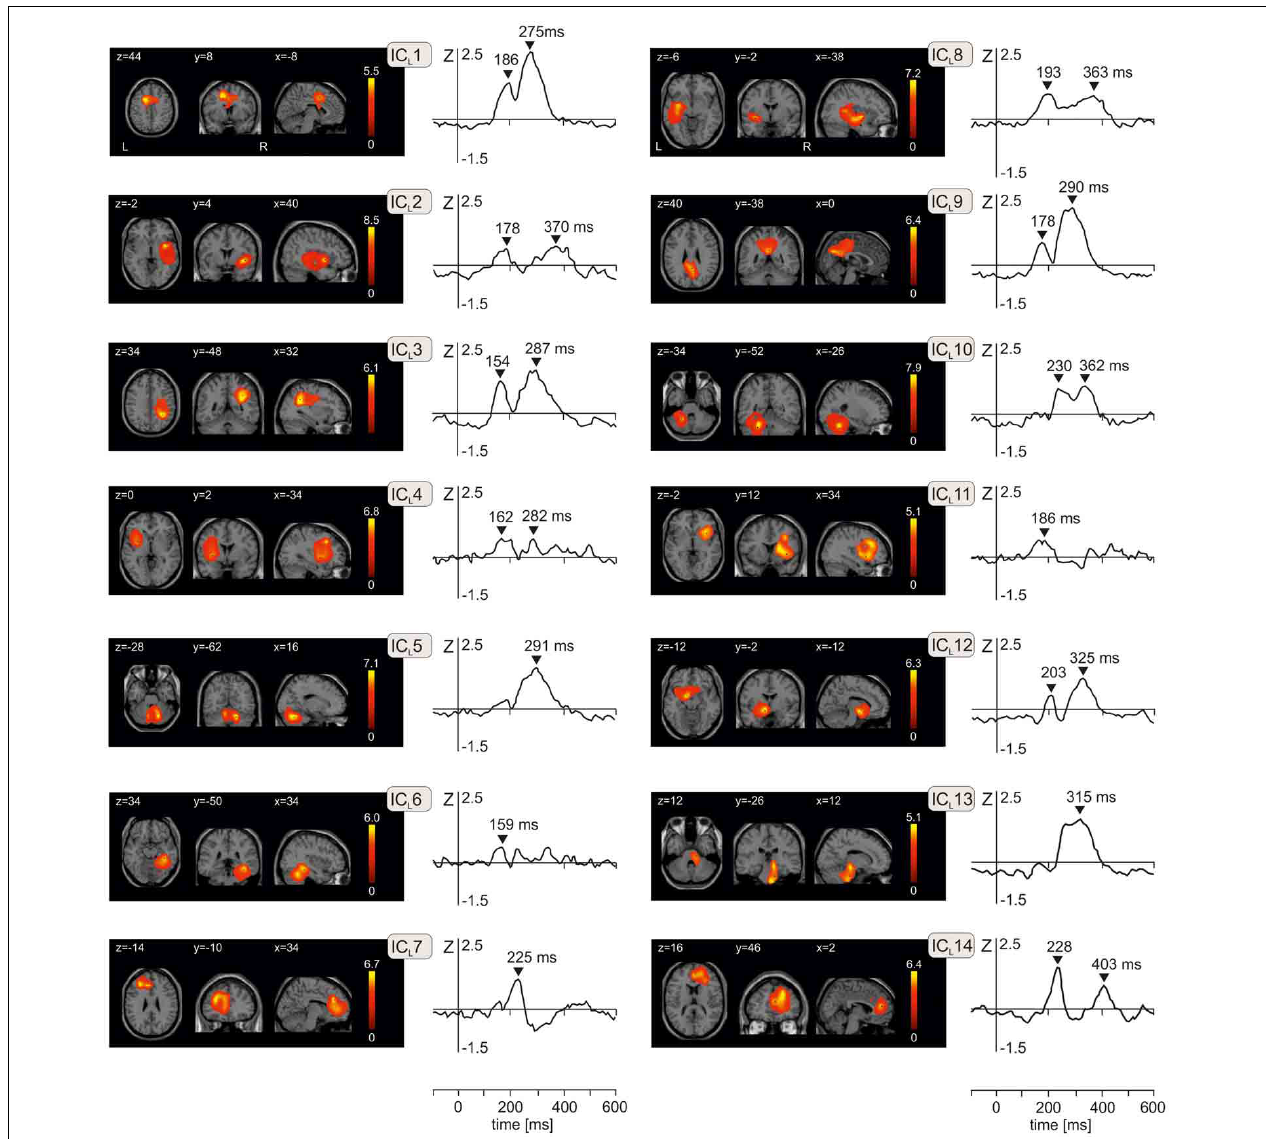
FIGURE 2 | The component T -maps and component time courses of 14 independent components representing activation changes during the period of laser evoked potentials from − 100ms to 600ms. Independent components are numbered from IC L 1 to IC L 14. In each of